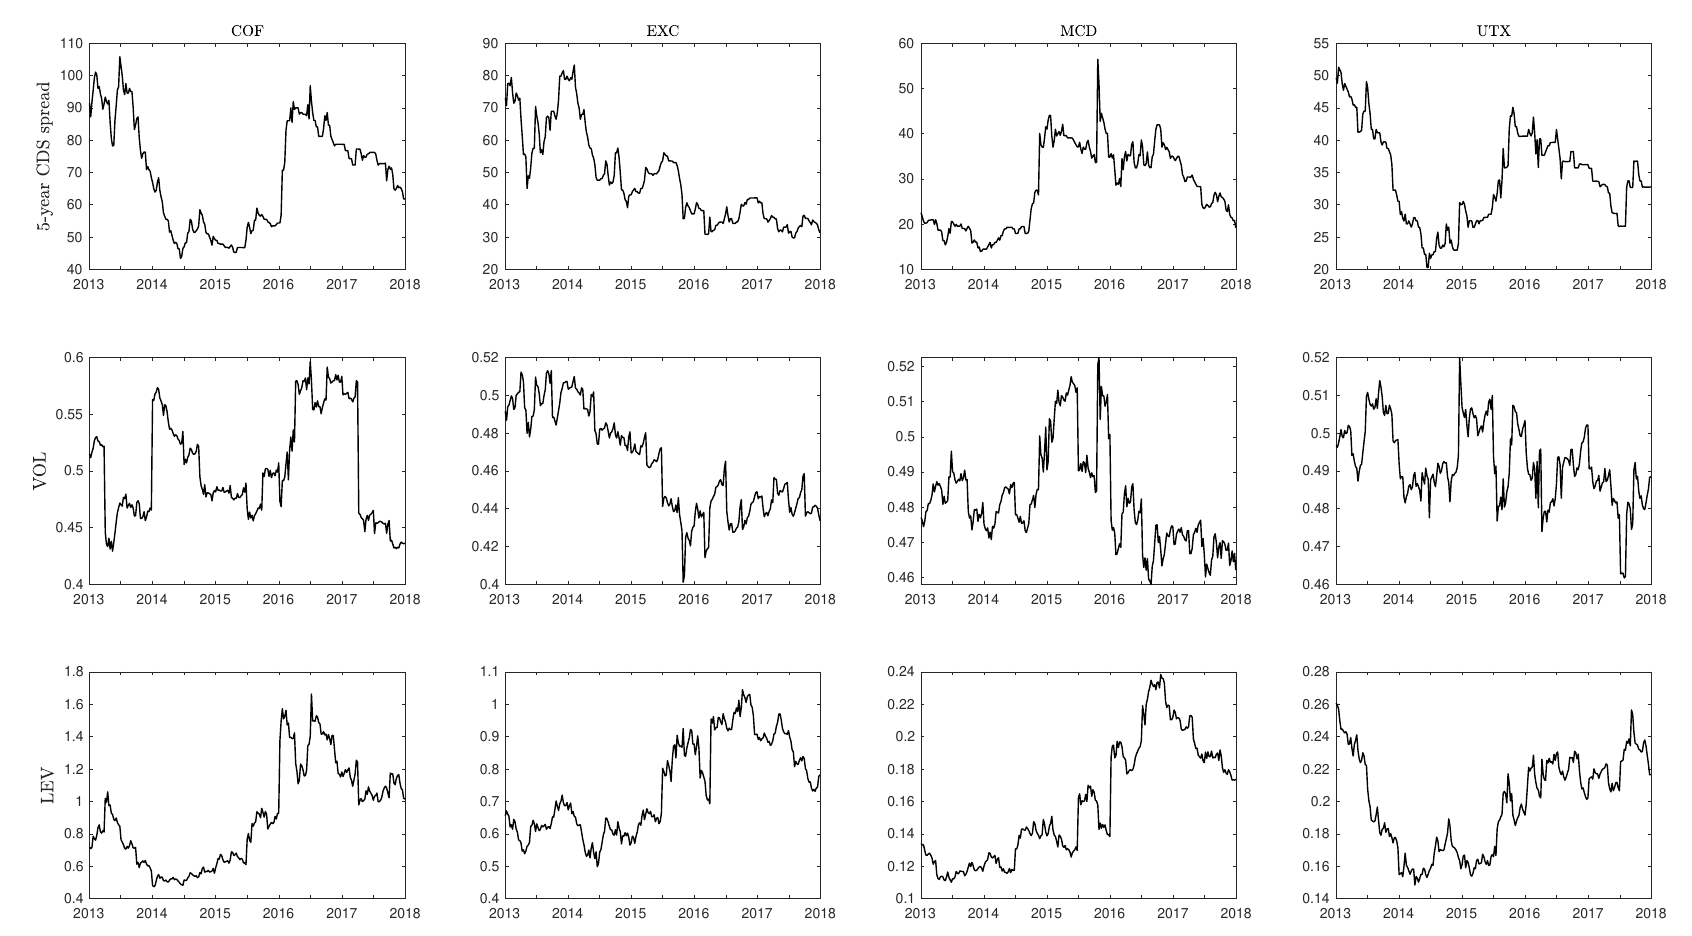
Figure 2. Time series of the 5-year CDS spreads ( top ), equity volatility ( middle ) and financial leverage ( bottom ) estimated as in (9) for four different companies: Capital One Financial (financials), Exelon (mining, energy and utilities), McDonald’s (retail, wholesale and services), and United Technologies (manufacturing). Visual inspection suggest non-stationarity and a strong comovement of the three variables. The non-stationarity of the time series is confirmed by unit root